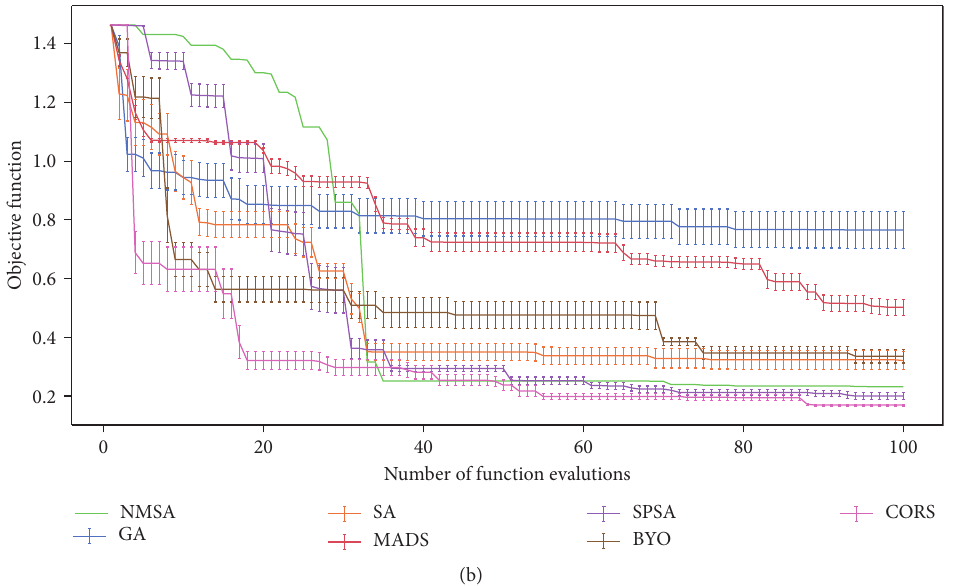
Figure 5: Algorithm performance in the two train capacity scenarios. (a) Crowding-insensitive. (b) Crowding-sensitive.